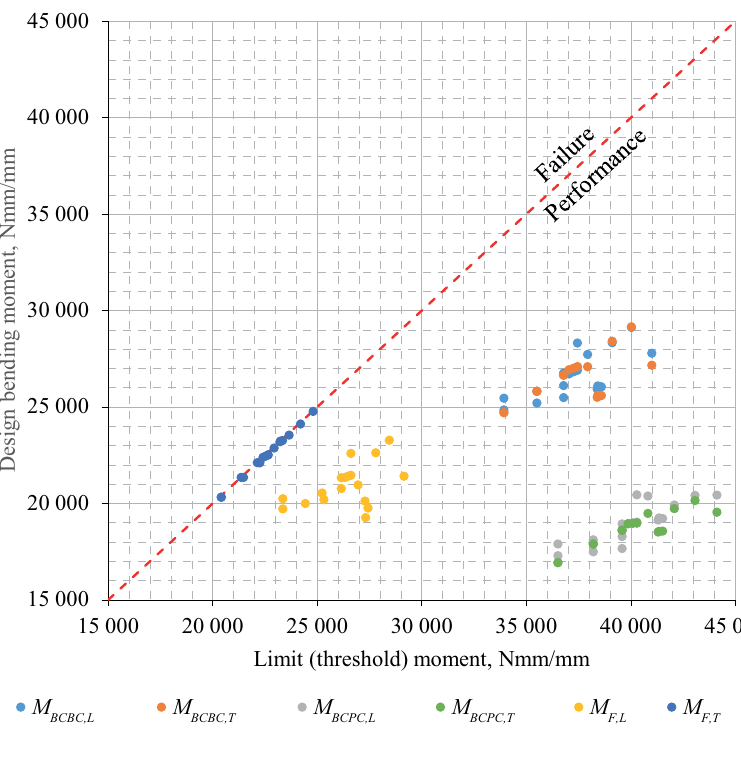
Figure 6. The relation between boundary conditions design and limit (threshold) bending moments